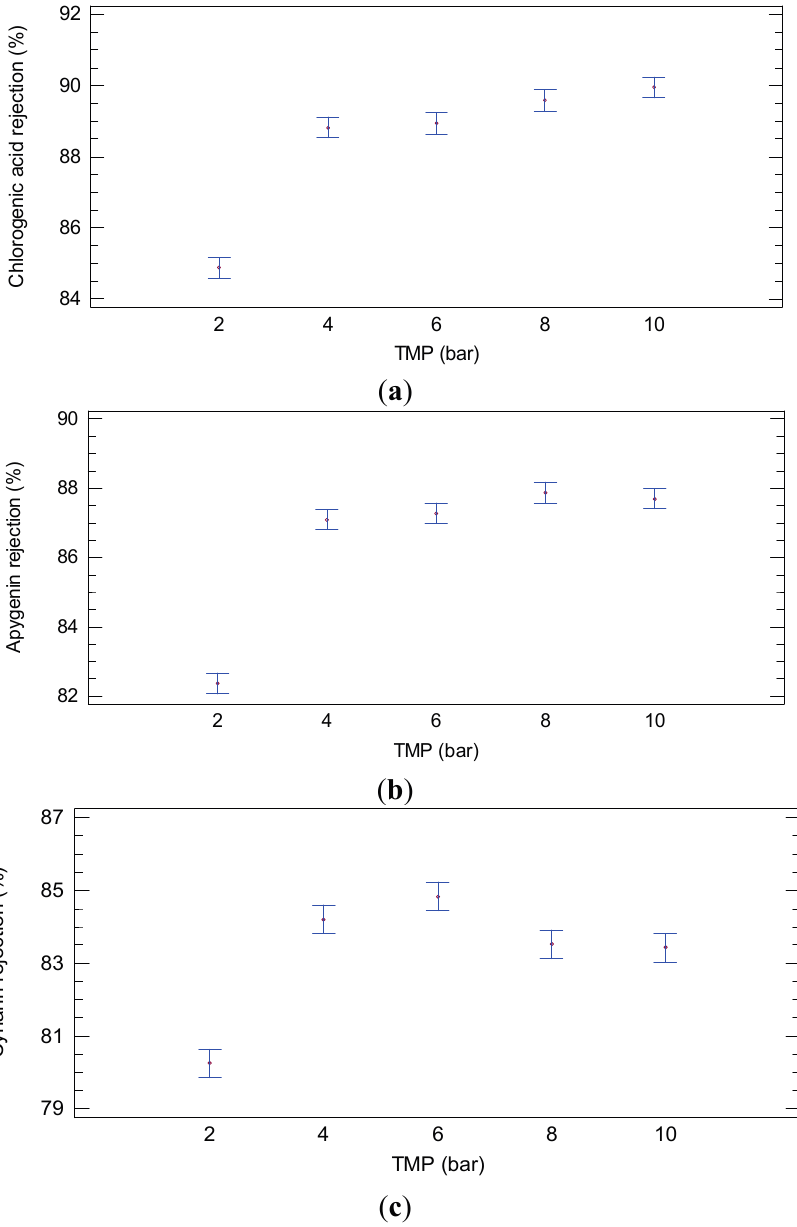
Figure 1. Least significant difference (LSD) plot showing the effect of transmembrane pressure (TMP) on the rejection of ( a ) chlorogenic acid ( b ) apygenin and ( c ) cynarin (NP030 membrane, total recycle configuration, 25